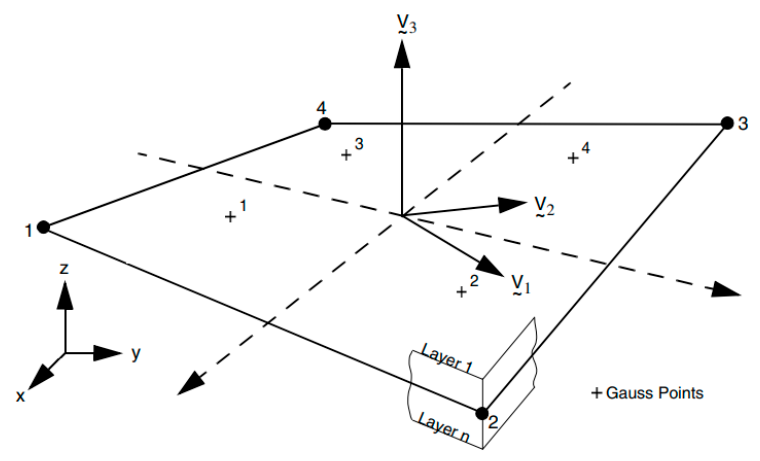
Figure 5. Element geometry